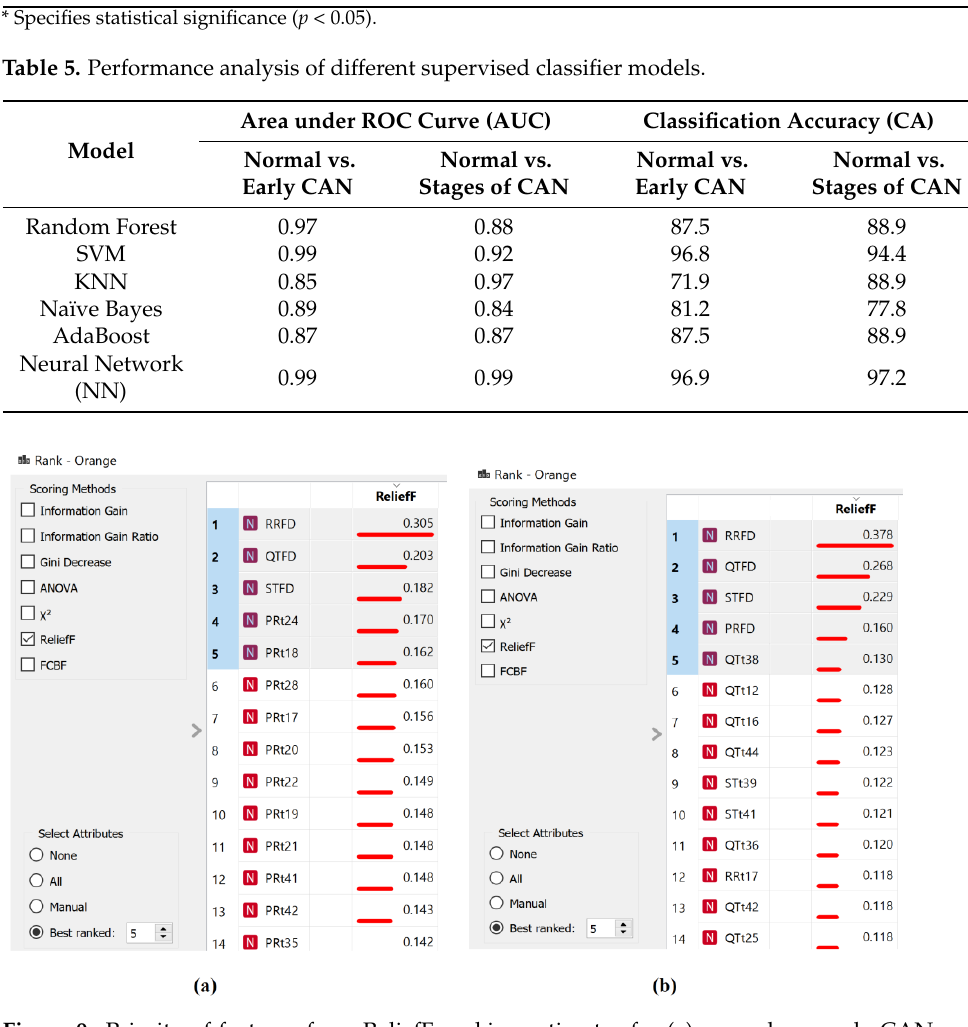
Figure 9. Priority of features from ReliefF ranking estimator for ( a ) normal vs. early CAN, and ( b ) normal vs. other stages of CAN.